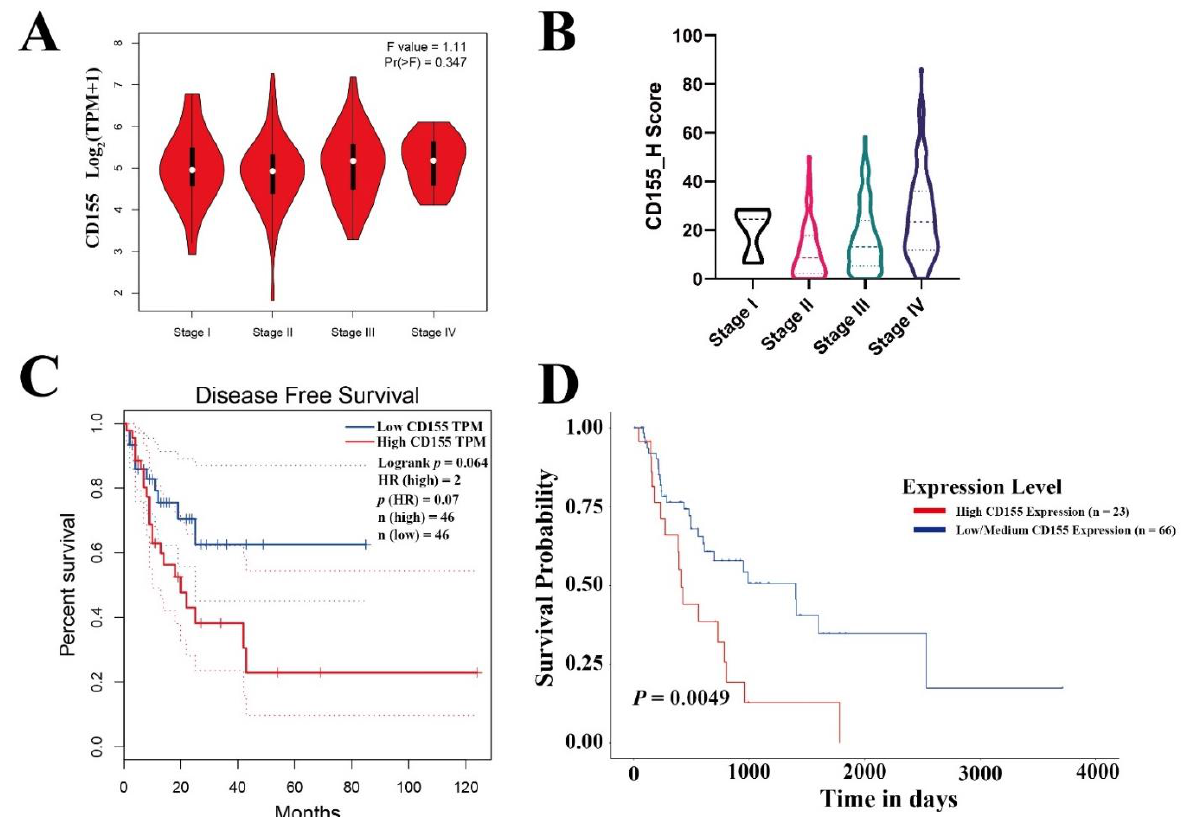
Figure 2. CD155 is expressed in all cancer stages and associated with poor patient prognosis. ( A ) The expression of CD155 in the different stages of ESCA was evaluated using the GEPIA database, the numbers in the Y axis indicate the transcription level of CD155. ( B ) The expression of CD155 in the different stages of ESCA was validated by performing immunohistochemistry, the numbers in the Y axis indicate the protein level of CD155. Survival analyses related to CD155 were performed in the ( C ) GEPIA and ( D ) UALCAN databases.